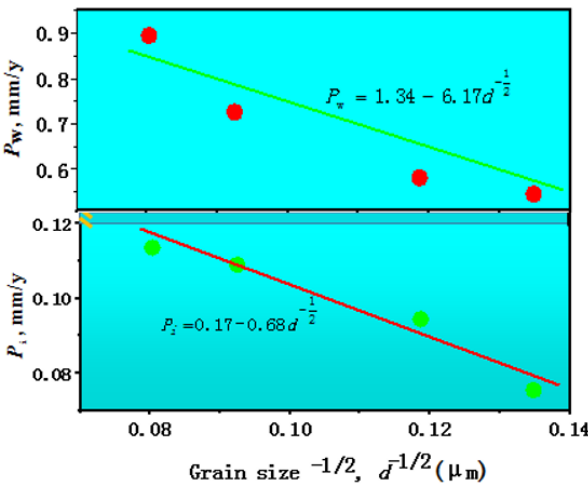
Figure 8. The relation between the biodegradation rate ( P i or P w ) and the average ferrite size ( d ).